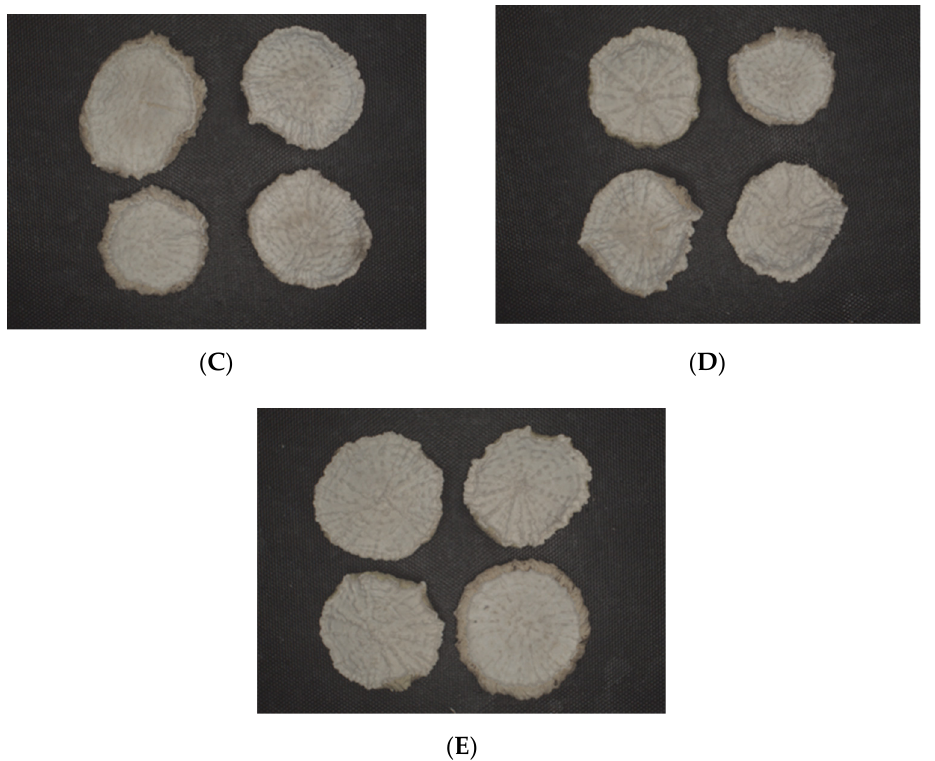
Figure 5. Overall appearances of white radish slices under different drying conditions: ( A ) control; ( B ) temperature of 60 °C and constant RH of 20% to the end; ( C ) temperature of 60 °C and constant RH of 40% to the end; ( D ) temperature of 60 °C and step-down RH values of 40% (150 min) and then 20% to the end; ( E ) temperature of 60 °C and automatic-down RH.